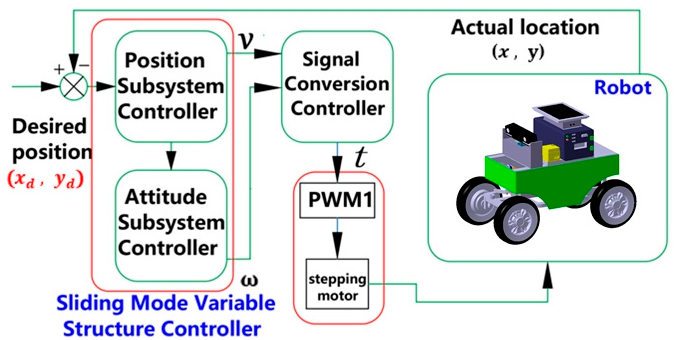
Figure 9. Sliding mode variable structure control strategy.